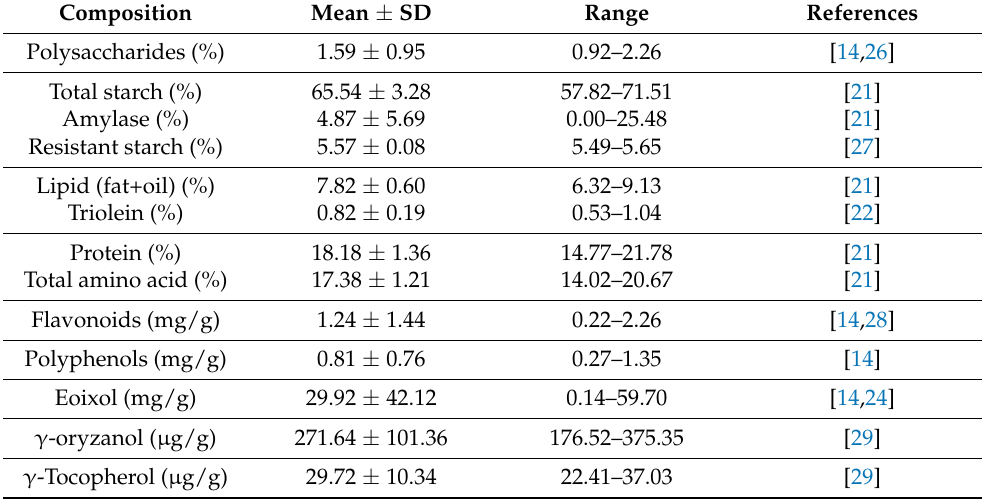
Table 2. Nutrition and functional ingredients of adlay